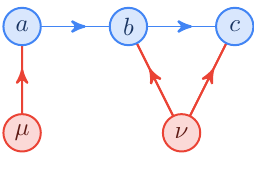
Figure 7: The Instrumental